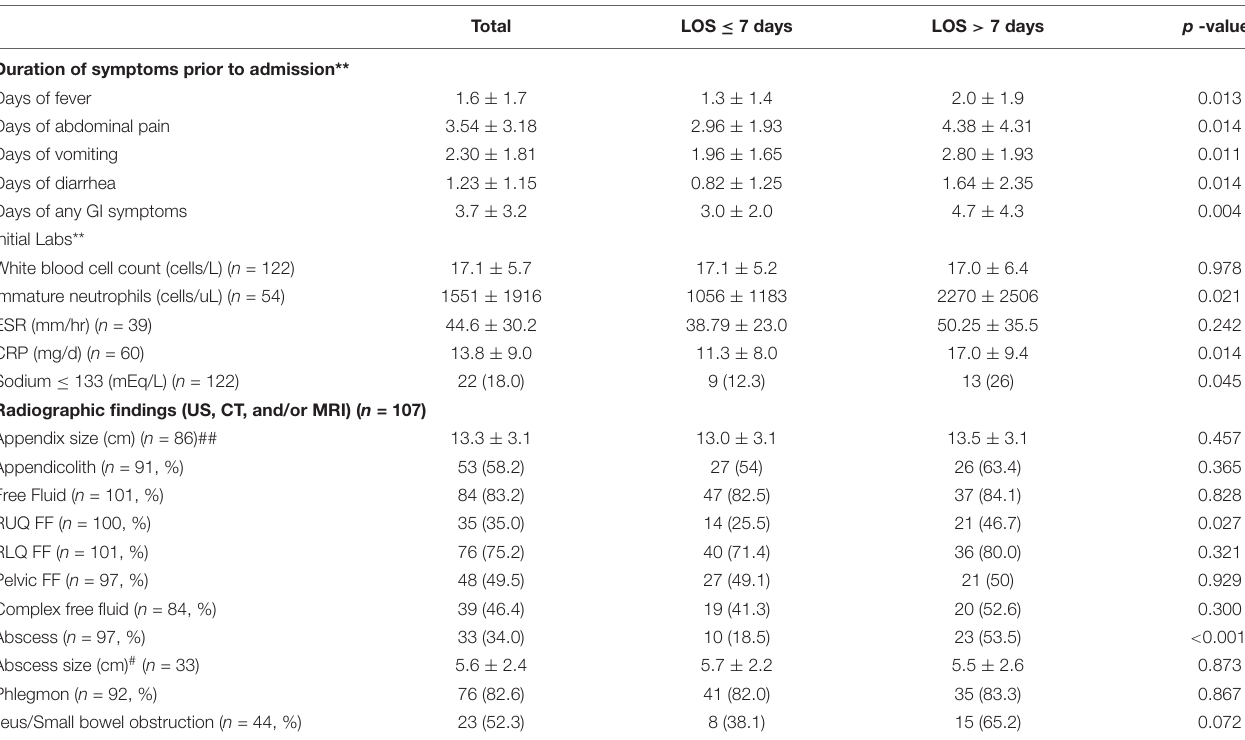
TABLE 2 | Clinical, laboratory and radiographic features of cohort by dichotomized